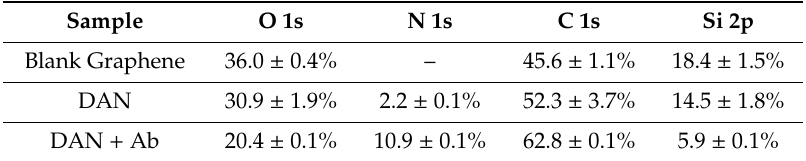
Table 1. Atomic concentrations derived from O 1s, N 1s, C 1s and Si 2p regions obtained via XPS of successive antibody functionalization